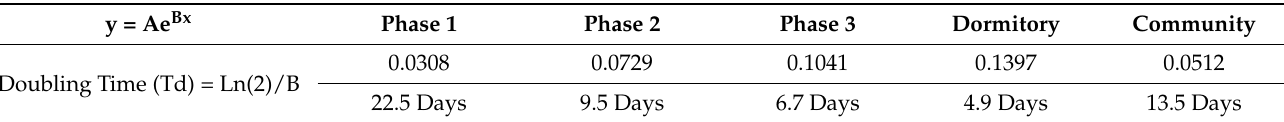
Table 2. Doubling times of COVID-19 progression in Singapore from 23 January–1 May 2020. y = Ae